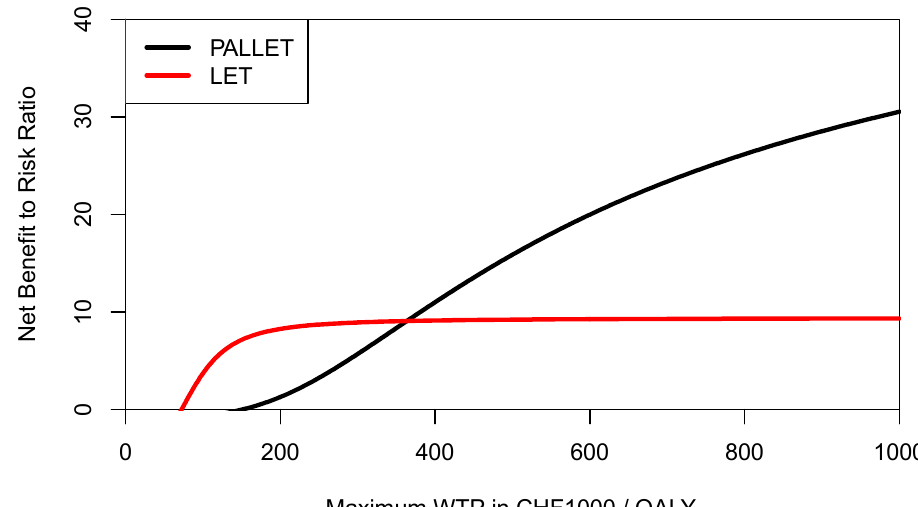
Figure 8. Cost-effectiveness risk-aversion curve (CERAC) of PALLET (palbociclib and letrozole) versus LET (letrozole) in patients with metastatic ER + HER2- breast cancer. CERACs are estimated using the mean NMB of LET to estimate the downside deviation for both PALLET and LET.